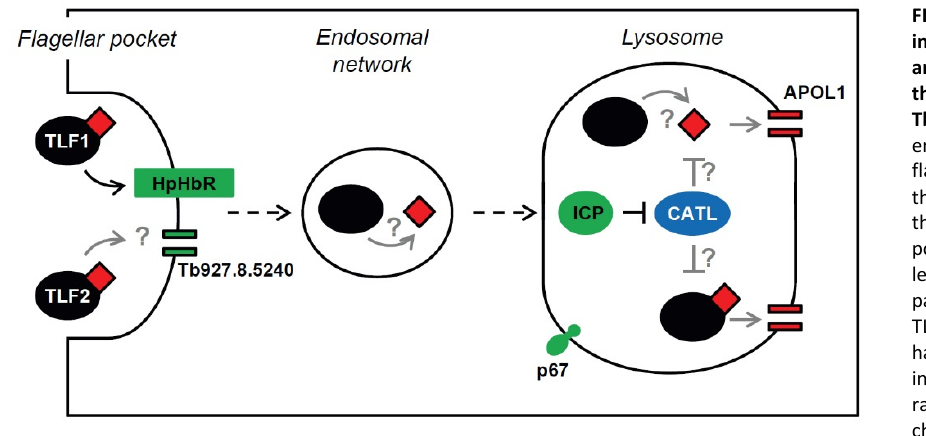
FIGURE 1: Speculations on the interactions between TLF, APOL1